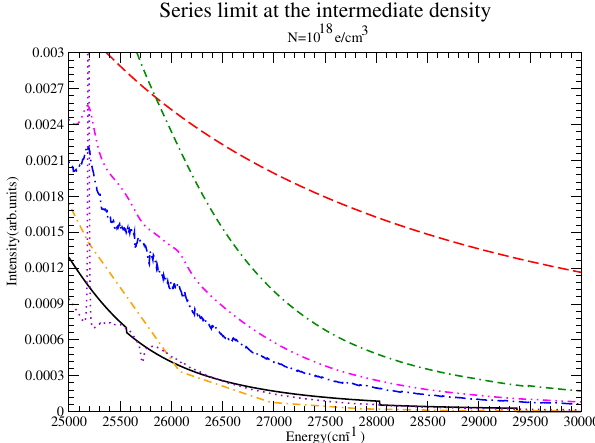
Figure 17. Comparision of line widths. Shown are QC-FFM (solid), PPP (dashed), DWE (dash-dotted), CONVST without strong collisions (dotted), CONVST with strong collisions (dot-double dashed), CONVPST without strong collisions (long dash-dotted) and CONVPST with strong collisions (dash-double